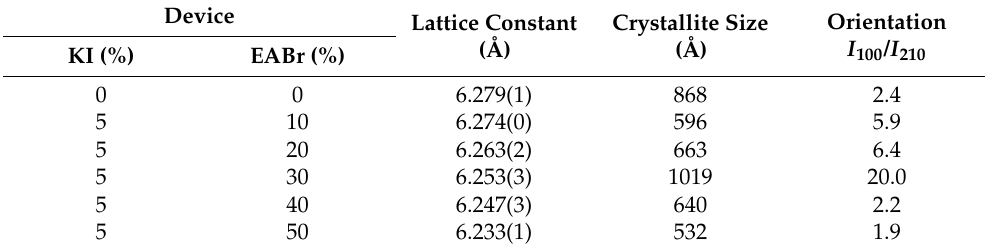
Figure 3. ( a ) Optical microscope images of perovskite solar cells. ( b ) X-ray diffraction patterns of the perovskite solar cells. Table 2. Structural parameters of perovskite crystals with added KI and EABr.